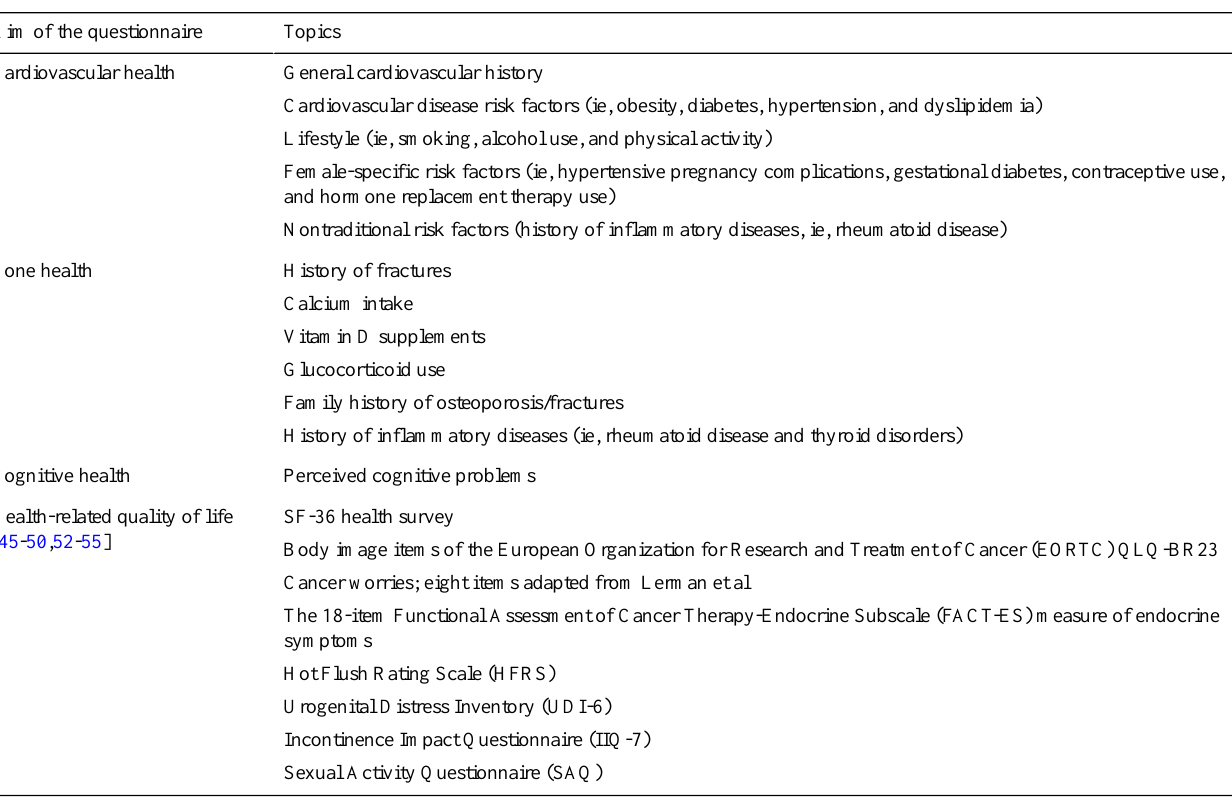
Table 2. Overview of the